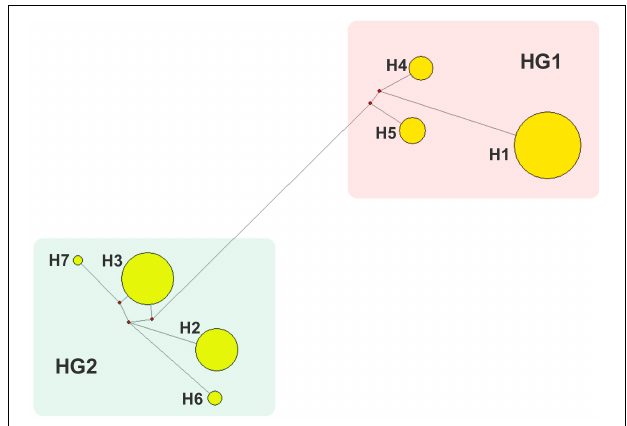
FIGURE 1 | Network analysis of mitotypes. 7 mitotypes clustered into two mitogroups, HG1 (H1, H4, and H5) and HG2 (H2, H3, H6, and H7).